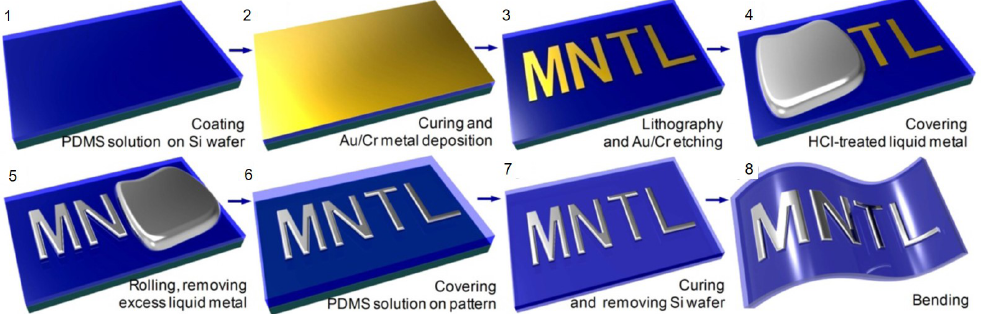
Figure 6. Fabrication process of the liquid metal pattern embedded in PDMS. (1) Spincoating the PDMS solution onto a silicon wafer. (2) PDMS curing, oxygen plasma treatment or parylene deposition, and gold/chromium (100 nm/10 nm) deposition using an electron beam (E-beam) evaporator. (3) Photolithography and gold/chromium wet etching. (4) Dropping HCl-treated liquid metal onto the adhesion patterns. (5) Rolling of the liquid metal over the PDMS substrate and removing the excess liquid metal. (6) Covering the liquid metal pattern with a PDMS solution. (7) PDMS curing and separation of the silicon wafer. (8) Bending test. Reprinted from [58], Copyright (2015), with permission from